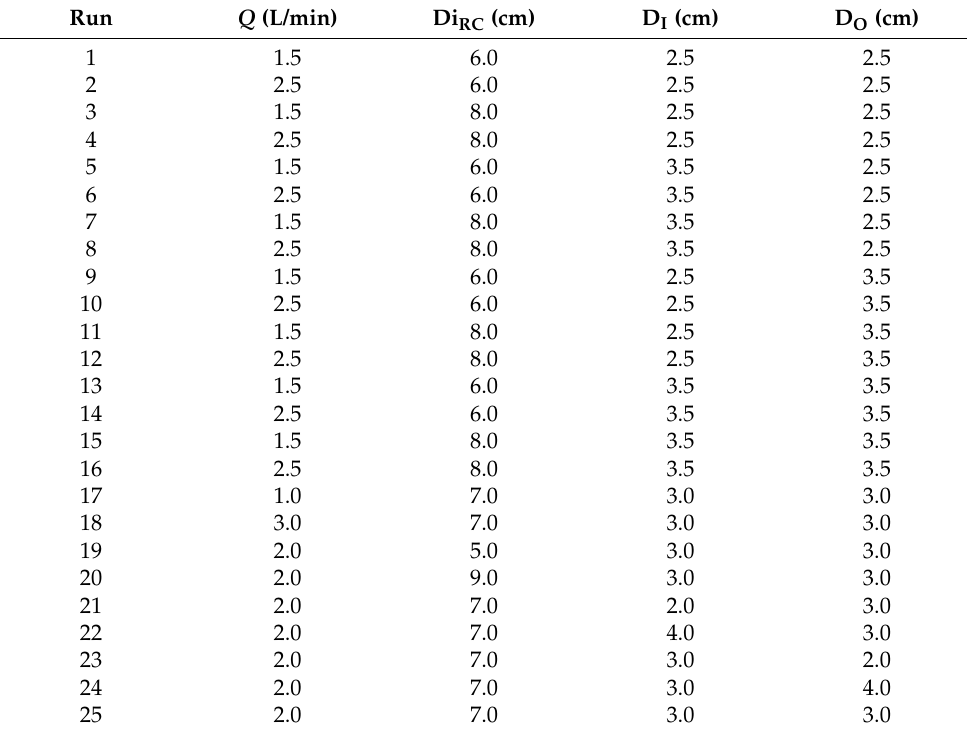
Table 3. Matrix of runs performed according to the lateral inlet and outlet factorial design.